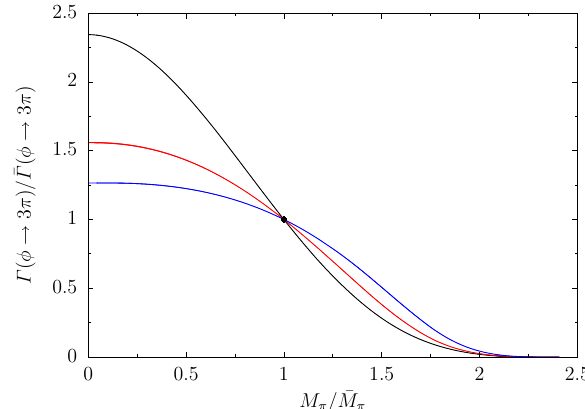
Fig. 8 Pion-mass-dependent decay width for φ → 3 π shown for three differentcases:kinematiccontributiononly(black),considering2-body FSI(red)andfull3-bodyFSI(blue).Thephysicalpointismarkedbythe black diamond. The error bands are generated by taking the uncertainty of the IAM phase shift δ( s ) into account, see Fig. 2 size that the dispersive representation derived in Sect. 3